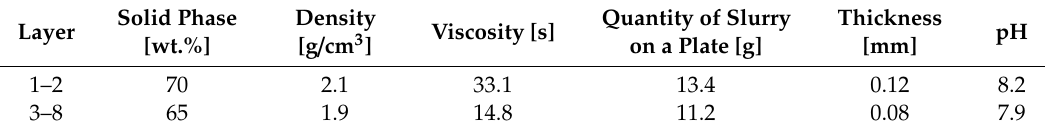
Table 3. Technological parameters of SiC-based ceramic slurries.